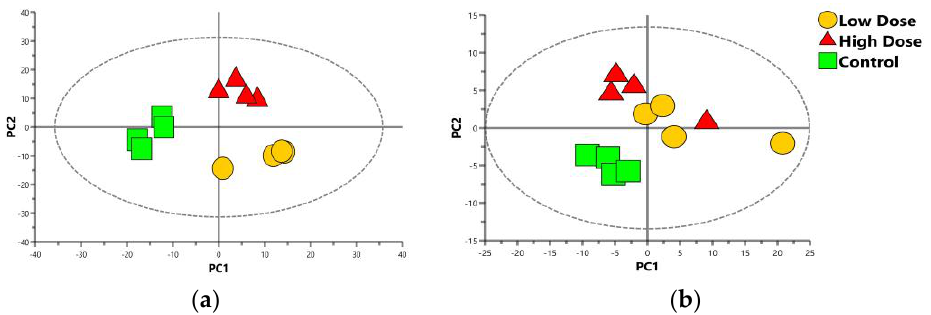
Figure 2. Partial least square discriminant analysis (PLS-DA) score plots of the milk lipidome of control, low-dose and high-dose samples. Metabolite data collected in the LC-MS positive (( a ), n = 2 components, R 2 Y = 0.99, Q 2 Y = 0.64) and negative (( b ), n = 2 components, R 2 Y = 0.61, Q 2 Y = 0.20) ionization modes.